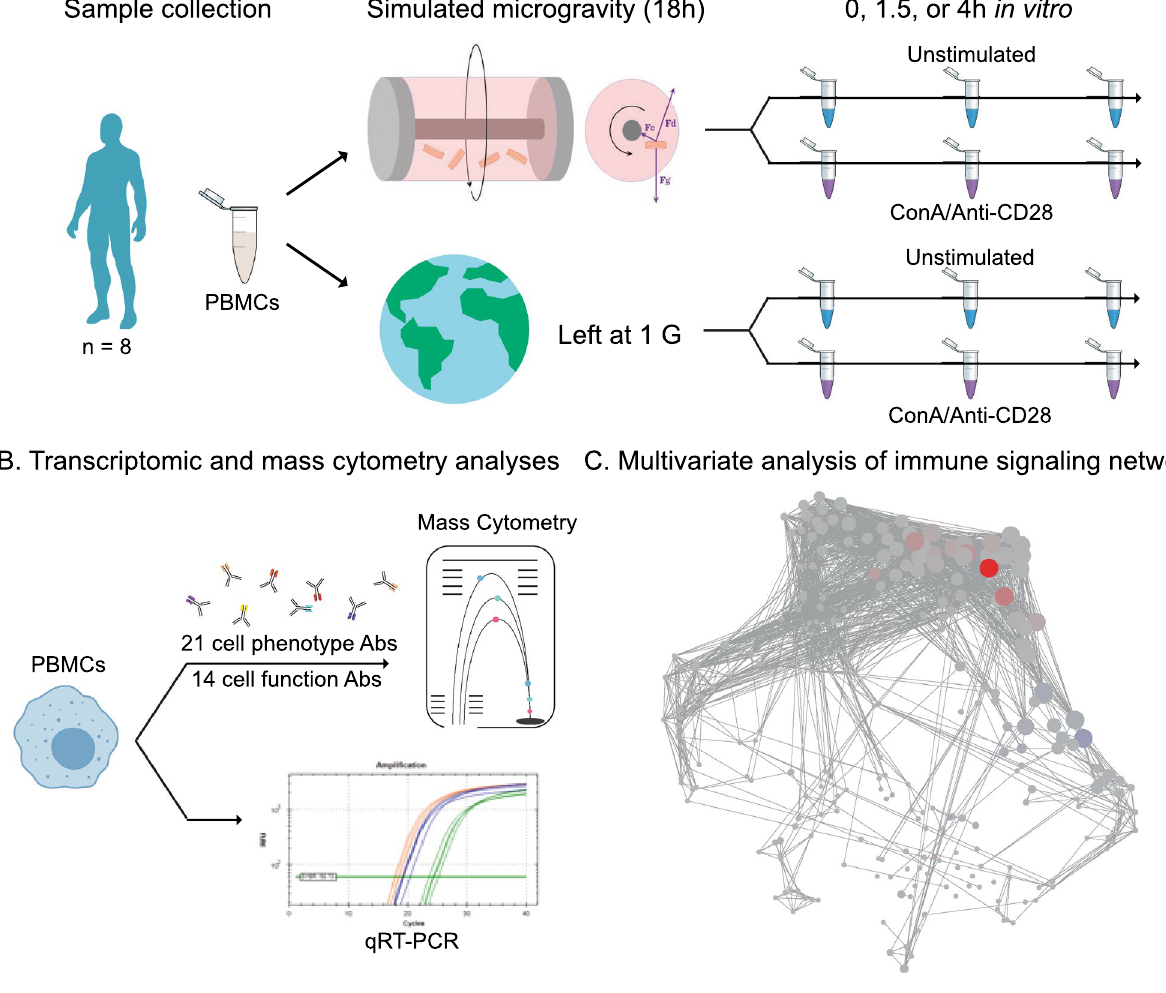
Figure 1. Experimental workflow. ( A ) Blood samples from eight healthy volunteers were collected. Peripheral blood mononuclear cells (PBMCs) were isolated and exposed to simulated microgravity (sµG) or (1G) (static control) using a random positioning machine for 18 h, then stimulated with ConA and anti-CD28 (ConA/ anti-CD28) or left unstimulated. ( B ) The activation and intracellular signaling responses of all major immune cell subsets were quantified using single-cell mass cytometry. In parallel, the mRNA expression of a select number of genes was quantified using qRT-PCR. ( C ) The high-dimensional immunological dataset was visualized as an immune signaling correlation network. Cell-type-specific immune responses that differed between the sµG and 1G conditions were identified using a multivariate Elastic Net (EN)